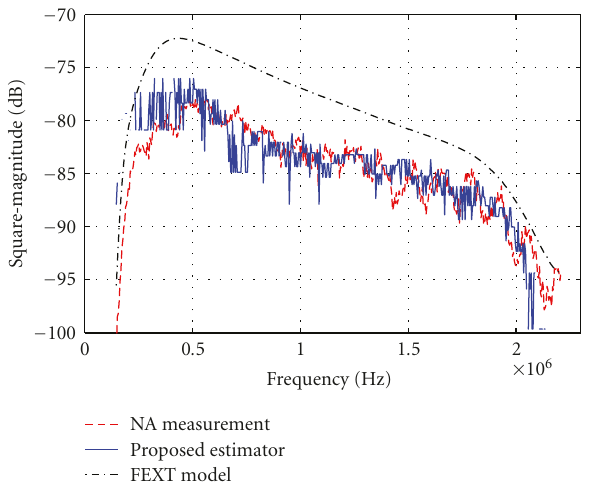
Figure 13: Square-magnitude of the upper (longer) FEXT channel for access network scenario II obtained with the NA, the FEXT model, and the proposed Estimator.